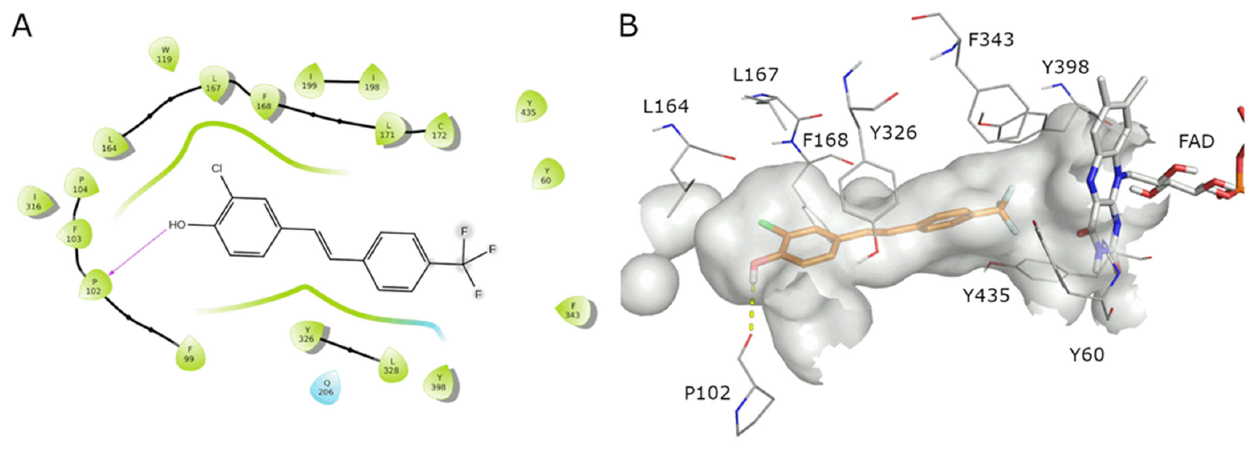
Figure 2. The catalytic site of MAO-B in complex with 4 . ( A ) The 2D ligand interaction diagram; ( B ) the best docked pose of ligand 4 (orange sticks) with the surrounding residues of MAO-B shown (grey lines).